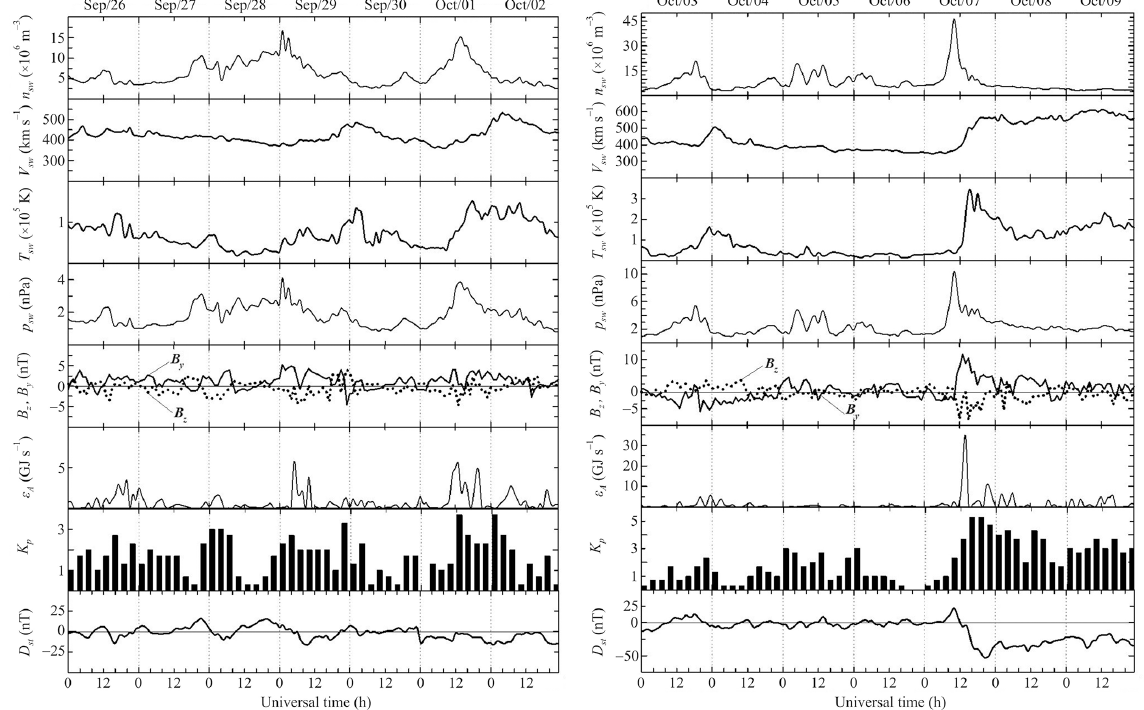
Figure 2. Universal time dependences of the solar wind parameters: proton number density n sw , plasma flow speed V sw , plasma temperature T sw , dynamic solar wind pressure p sw , B z and B y components of the interplanetary magnetic field, calculated energy input ε A into the Earth’s magnetosphere from the solar wind, and Kp and Dst indices for the 26 September–2 October and 3–9 October 2018